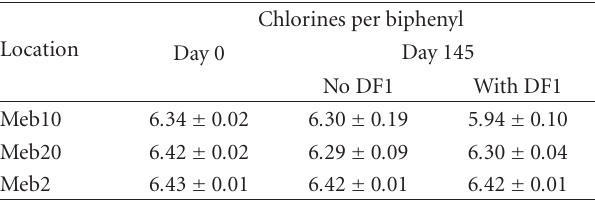
Table 5: Change in the number of chlorines per biphenyl over the five month incubation period for the bioaugmentation experiments with DF-1.